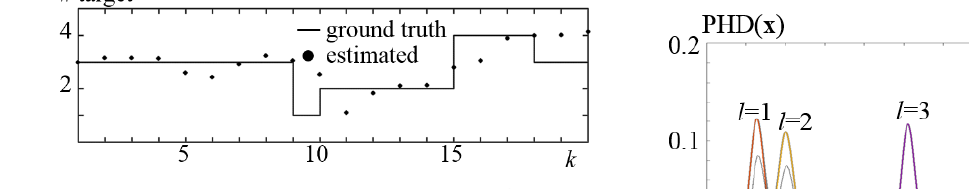
Figure 7. Number of targets at each time k